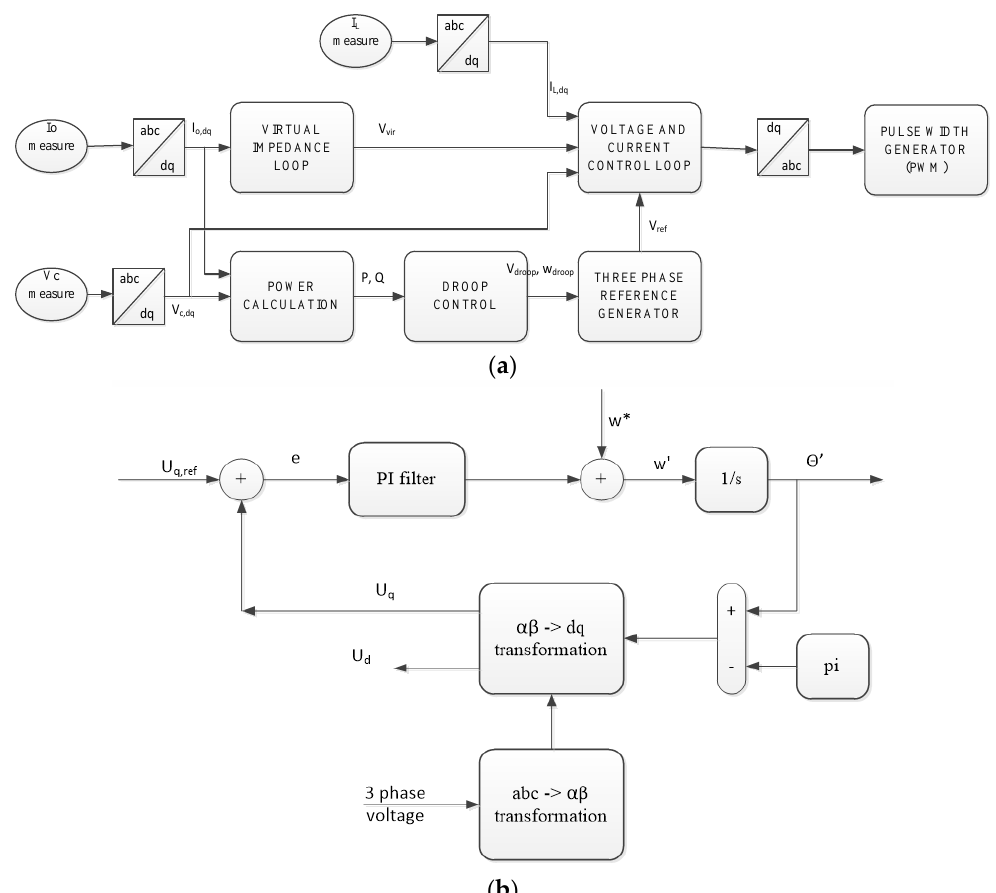
Figure 4. Simulation block diagram: ( a ) Block diagram of the control system of one inverter; ( b ) Structure of phase-locked loop (PLL).